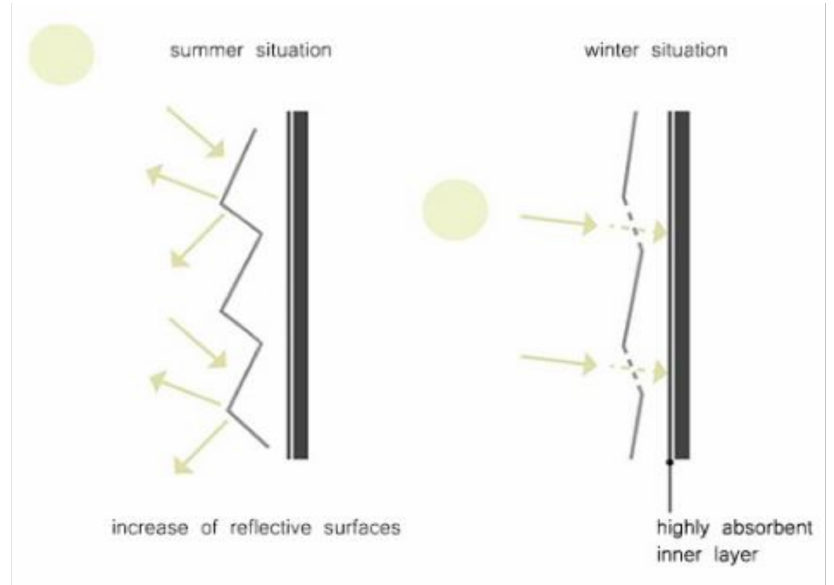
Figure 3. Design concept for the dual-seasonal